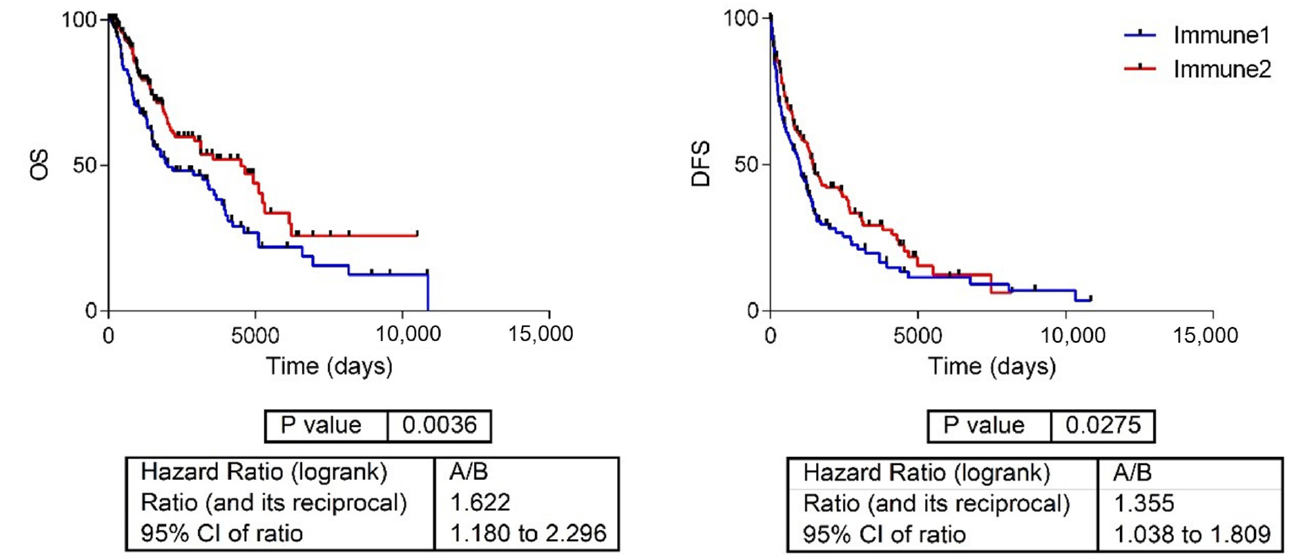
Figure 3. Survival curves according immune classification in the TCGA cohort. OS = overall survival. DFS = disease-free survival.